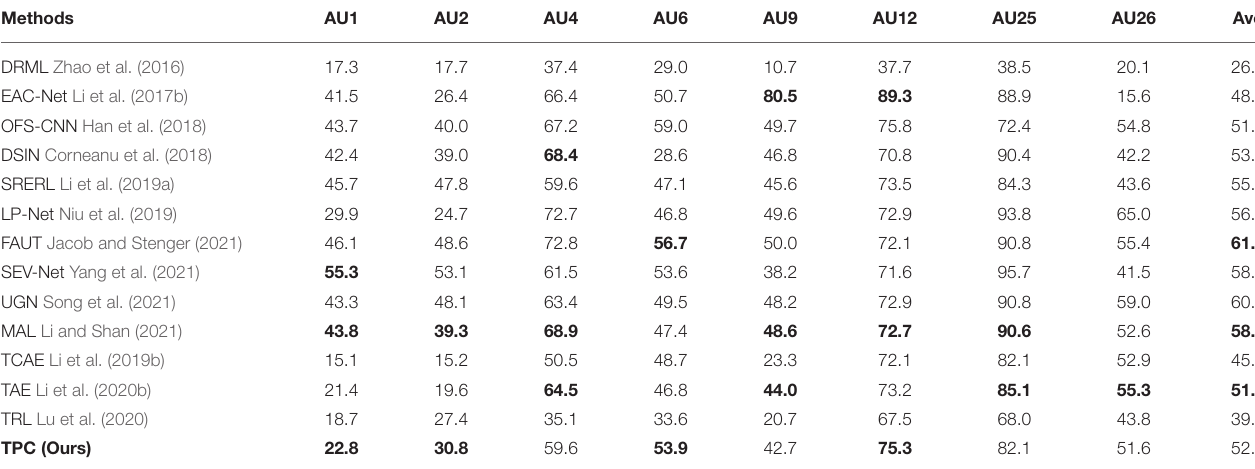
The best results in the supervised and self-supervised methods are illustrated in Bold.